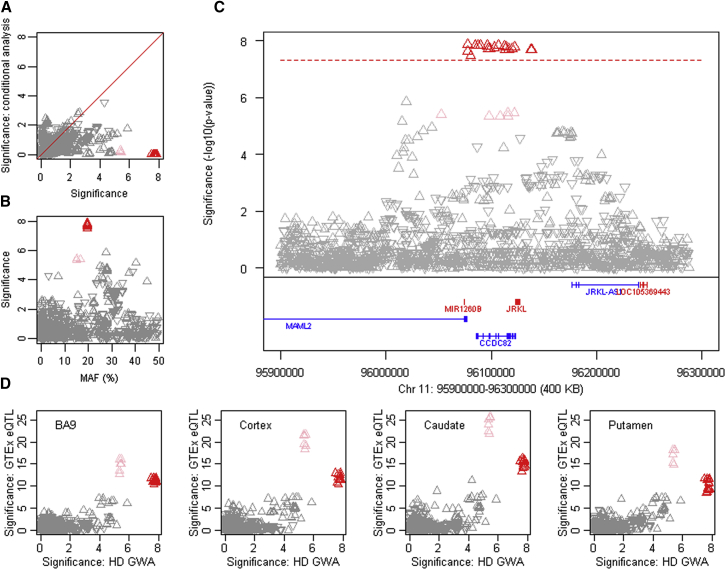
An Onset Modification Signal at CCDC82(A) SNP significance in dichotomous analysis conditioned on the top 11AM1 (red) SNP compared to GWA12345 significance reveals the presence (with subsequent analyses) of a related haplotype (pink triangles).(B) SNP significance compared to MAF, revealing a slight difference for tag SNPs of the closely related haplotypes.(C) SNP significance relative to genes in the region.(D) SNP significance in dichotomous analysis is compared to cis-eQTL signals for CCDC82 in GTEx consortium data for prefrontal cortex BA9, cortex, caudate, and putamen. In this case, the direction of the triangle indicates association of the minor allele with increased (upward) or decreased (downward) expression. Both related haplotypes (red and pink) show correlation with cis-eQTL SNPs associated with increased expression of CCDC82 in all 4 brain regions.See also Figure S7.